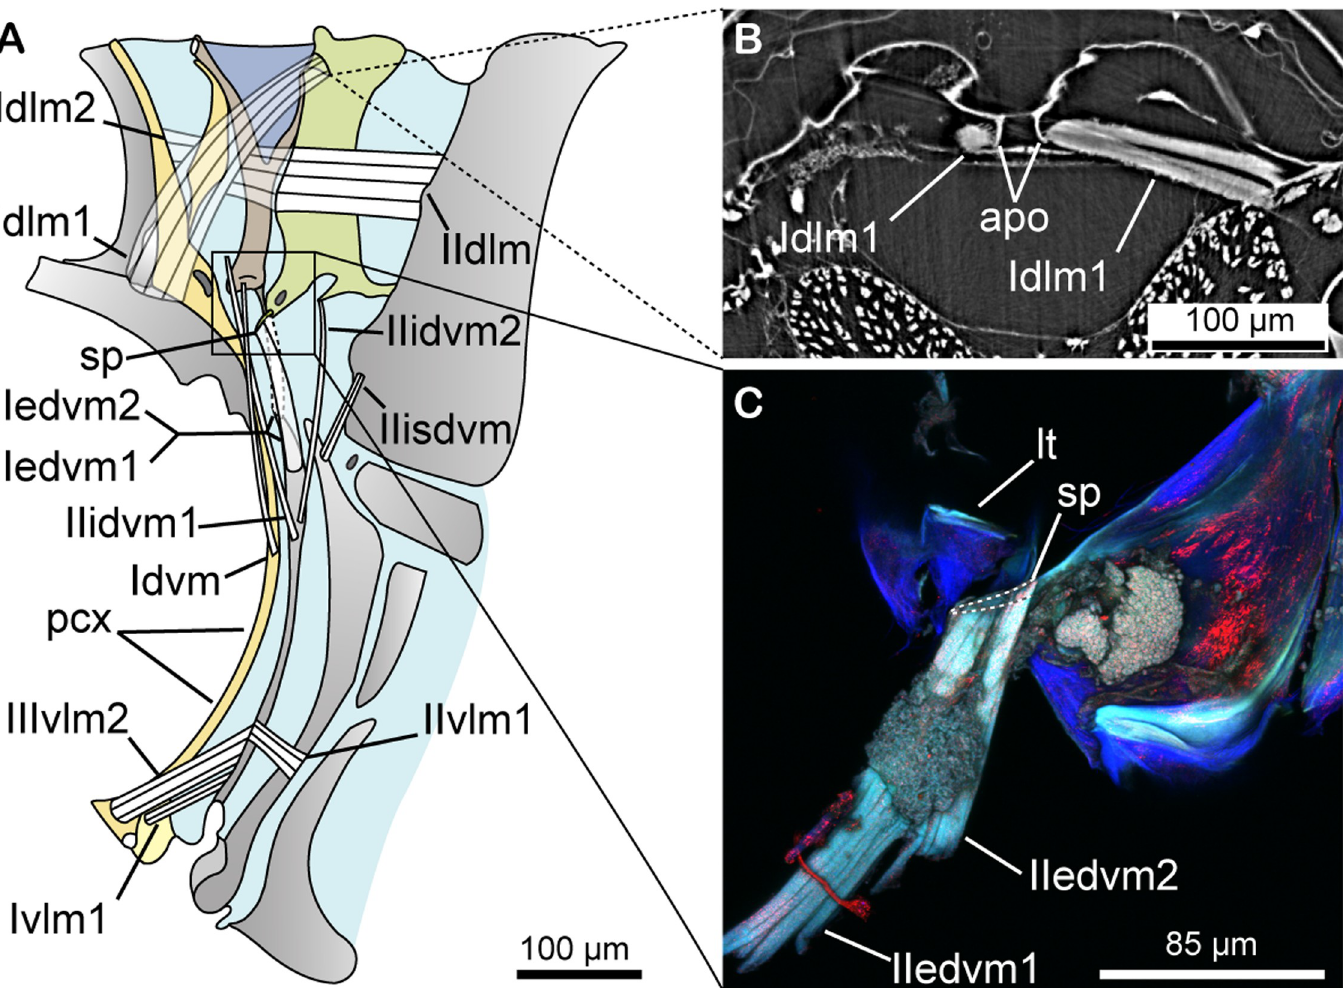
Fig 2. Generalized schematic of internal structure and musculature of the snapping organ. (A) Complete musculature of the first two abdominal segments. Square inset marks ventral junction of the lb base and tg2. (B) Transverse SR- μ CT section of muscle-bearing apodeme of segment two, with hypertrophied Idlm1 inserting on it. (C) Confocal laser scanning microscopy image of lateral view of lb base-tg2 junction, with primary DVMs IIedvm1 and IIedvm2 inserting on sp (interrupted line). The angle of muscles IIedvm1 and IIedvm2 is somewhat distorted because of the fact that their ventral attachments have been severed. Colour coding of structures: yellow, rg; brown, lb; purple, rs membrane; green, tg2. Latin numerals for muscles indicate segmental identity, whereas Arabic numerals indicate muscle set. apo, apodeme of tergum 2; DLM, dorsal longitudinal muscle; DVM, dorsoventral muscle; edvm, external dorsoventral muscle; idvm, internal dorsoventral muscle; isdvm, intersegmental dorsoventral muscle; lb, Y-lobe; lt, list of base of Y-lobe; pcx, postcoxale; rg, ridge; rs, resilin; sp, spine of tergum 2; SR- μ CT, synchrotron radiation microcomputed tomography; tg2, tergum 2; vlm, ventral longitudinal muscle.